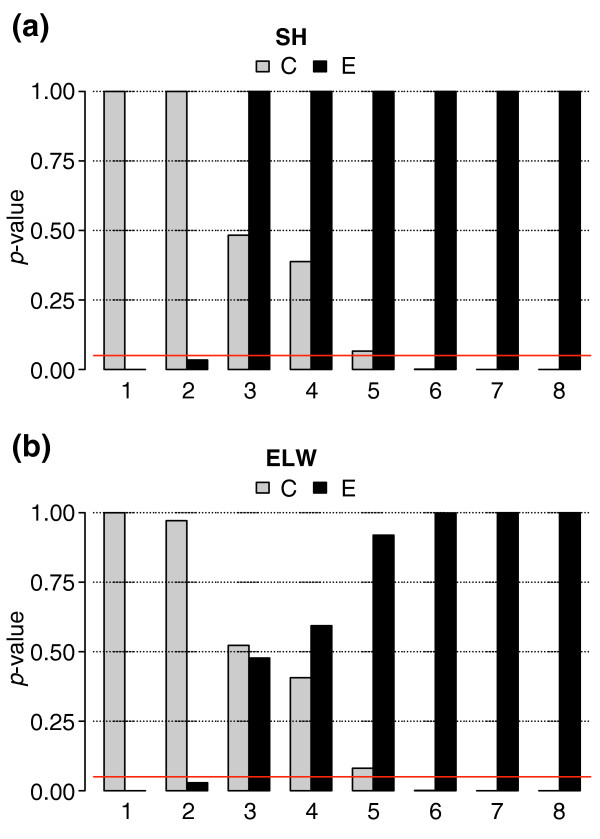
Paired-sites tests. p-values inferred from paired-sites tests considering Coelomata (C) and Ecdysozoa (E) hypotheses at the 5% level (red line) for all the datasets. (a) Shimodaira-Hasegawa test (SH); (b) expected-likelihood weight method (ELW).